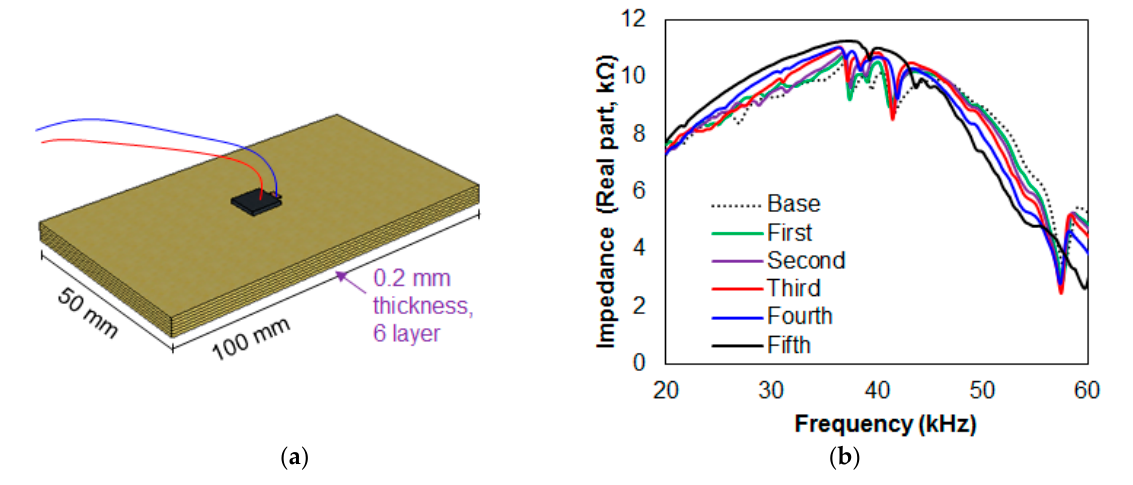
Figure 3. ( a ) Second debonding test scenario; ( b ) results from the second debonding test.